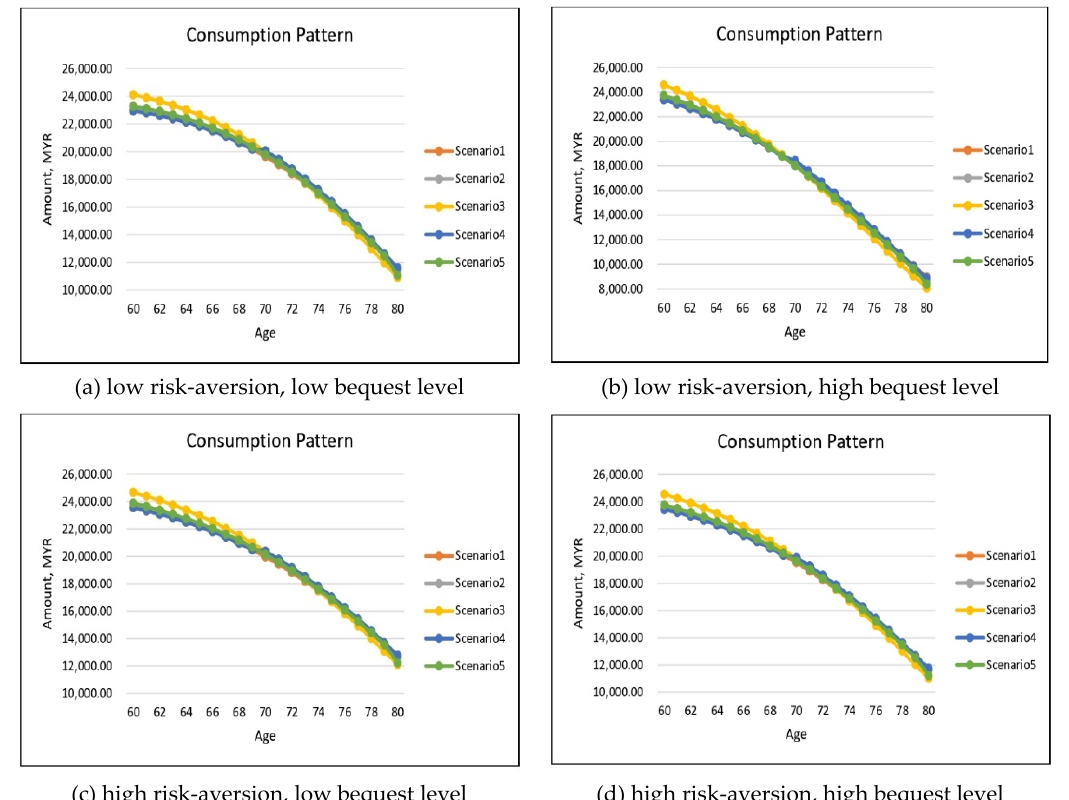
Figure 4. Optimal Consumption Pattern for Males (Health-Independent Utility).